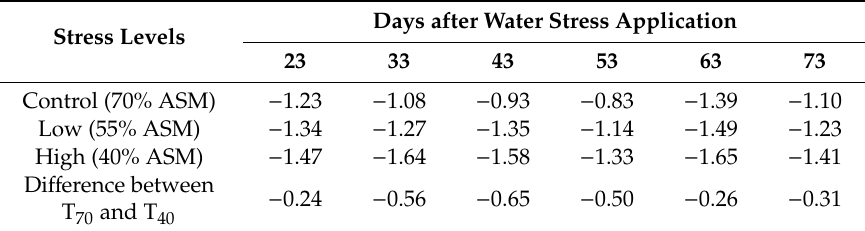
Table 2. Leaf water potential of castor plants (in MPa, mean values, n = 5). Days after Water Stress Application Stress Levels